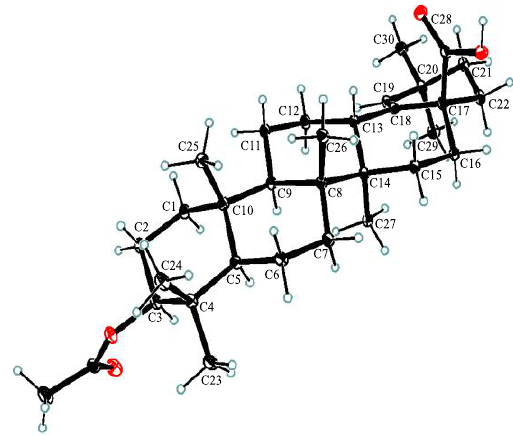
Figure 4. Single-crystal X-ray structure of 3 .